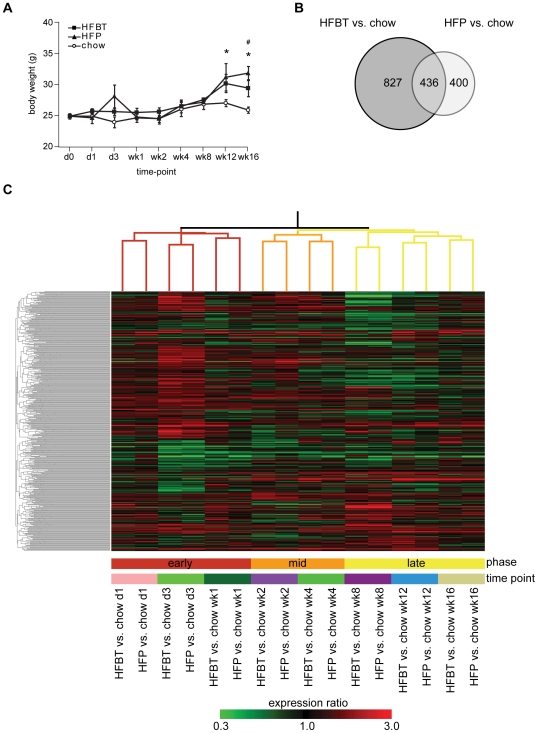
Increased body weight and gene expression changes induced by HFBT and HFP high-fat diets.(A) Average body weight of ApoE3L mice fed either chow, HFBT or HFP diet in each time point of the 16-week time course. Error bars represent standard deviation within a group. Statistically significant (p<0.05) increase in body weight of HFBT and HFP fed mice compared to chow fed mice are marked with asterisk and hash sign, respectively. (B) Overlap between the total numbers of statistically significant differentially expressed genes in livers of ApoE3L mice fed either HFBT or HFP diet compared to chow diet per time-point, over the 16-week time-course. (C) Hierarchical clustering (Pearson correlation, complete linkage) of 16 experimental conditions (two high-fat diets at 8 time-points) and 1663 genes differentially expressed under either of two high-fat conditions. Values used for clustering are average HFBT vs. chow and HFP vs. chow per time-point expression ratios. The branches of the condition tree are colored so to discriminate three subclusters with the largest distance, corresponding to three phases of the time-course: early (red), mid (orange) and late (yellow). This is summarized in the color bar underneath the cluster diagram. The lower color bar indicates distinct time-points, stressing the similarity of HFBT and HFP transcriptional response at each point of the time-course.